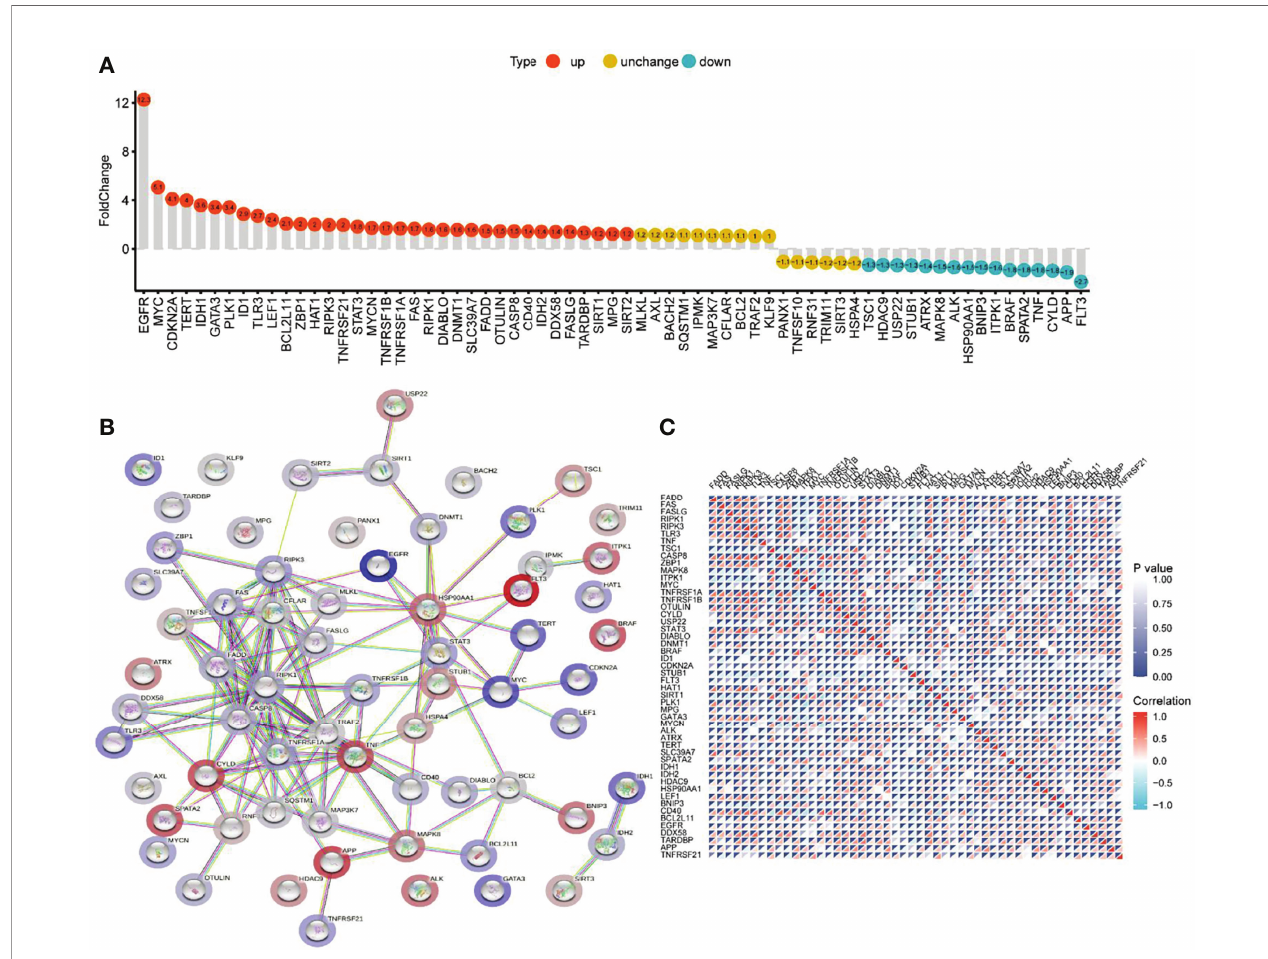
FIGURE 3 | The differential expression, PPI network, and expression correlation of NRGs. (A) Differential expression of NRGs in normal brain tissue and glioma. (B) The PPI network of NRGs. (C) The correlation of expression of